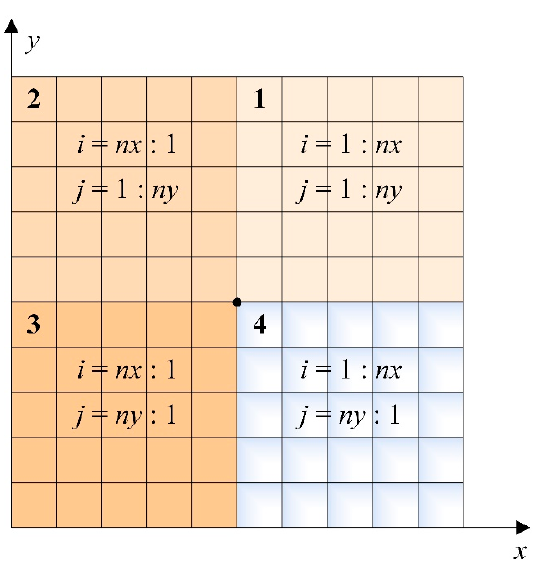
Figure 1. Fast sweeping method (FSM) grouping diagram.